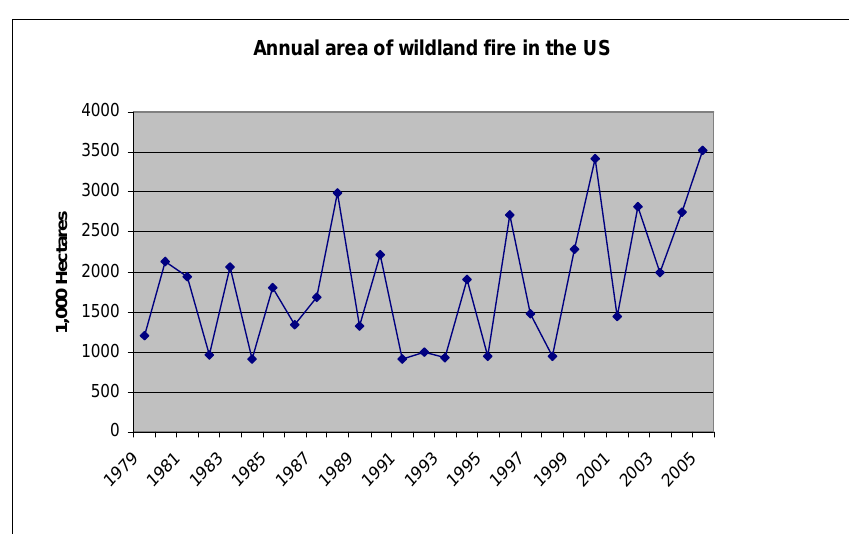
FIGURE 1 . Historic trend in forest fires for Canada[3].